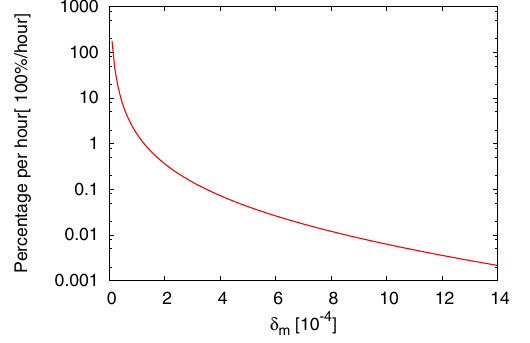
FIG. 18. Percentage of Au ions per hour having a relative momentum change δ due to the Touschek effect. In this m calculation, a 3-d Gaussian distribution bunch is